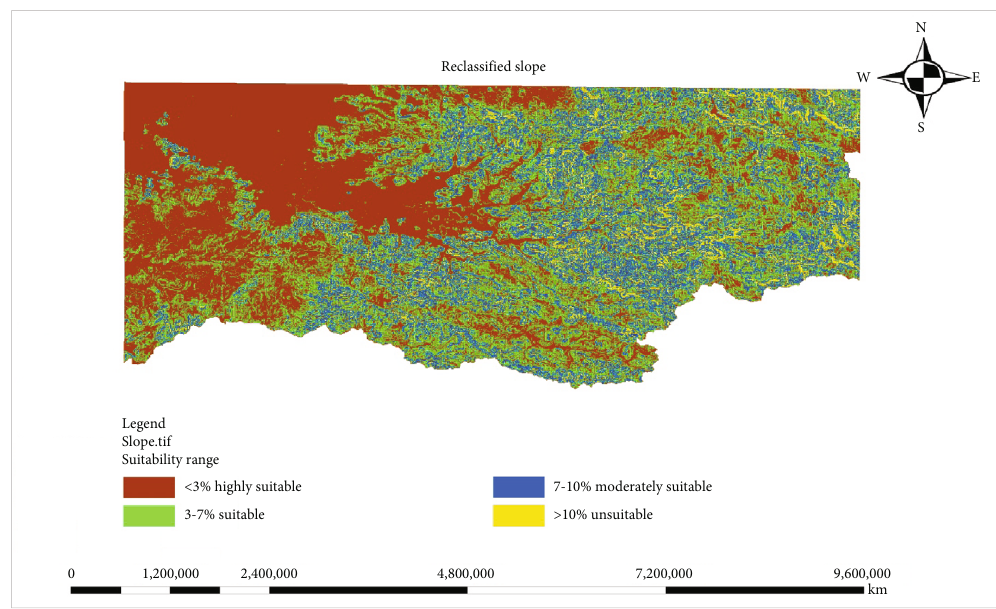
Figure 4: Suitable slopes for solar PV.